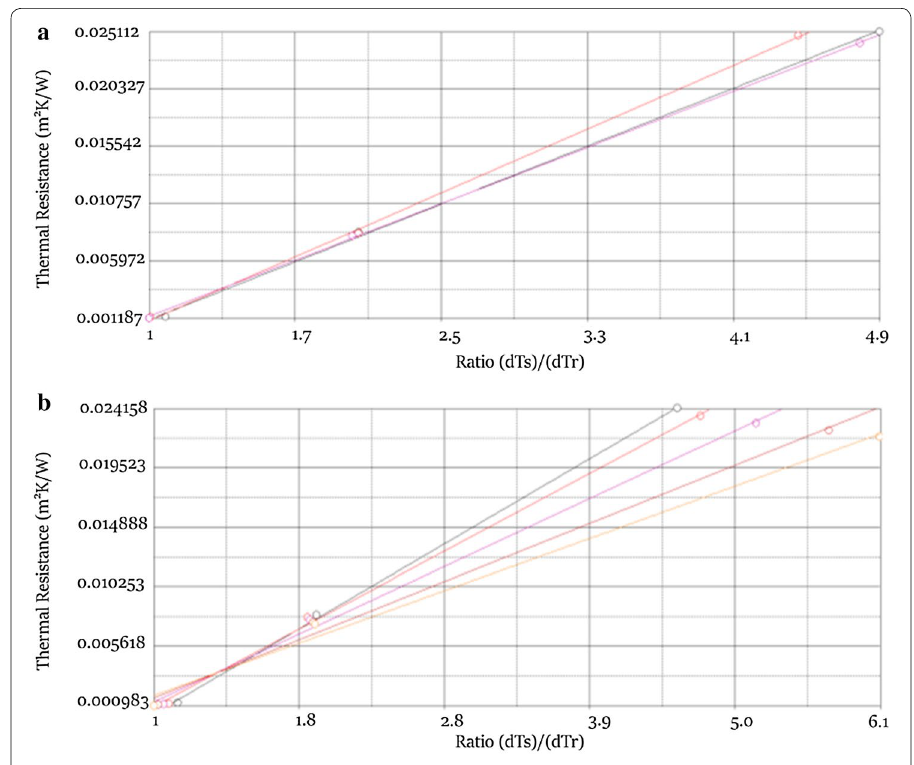
Fig. 3 a Calibration curve for low-temperature measurements (20–100 °C); black, red and purple lines correspond to 18.4, 34.0 and 83.6 °C temperature curves, respectively. b Calibration curve for high-temperature measurements (100–300 °C); black, red, purple, brown and yellow lines correspond to 83.7, 133.4, 183.4, 233.1 and 282.9 °C temperature curves, respectively. This is used to determine